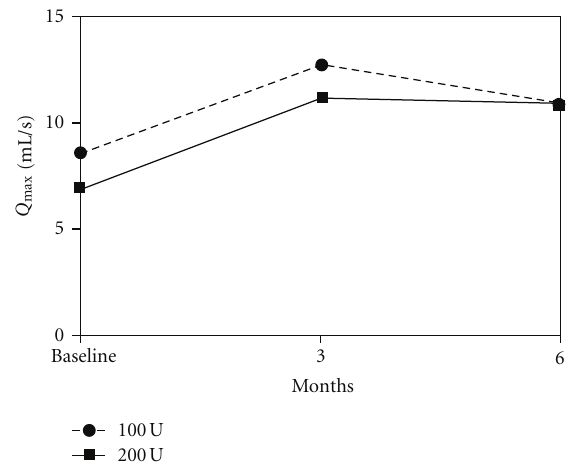
Figure 2: Mean Q max of 34 patients treated with 100 and 200 U of intraprostatic